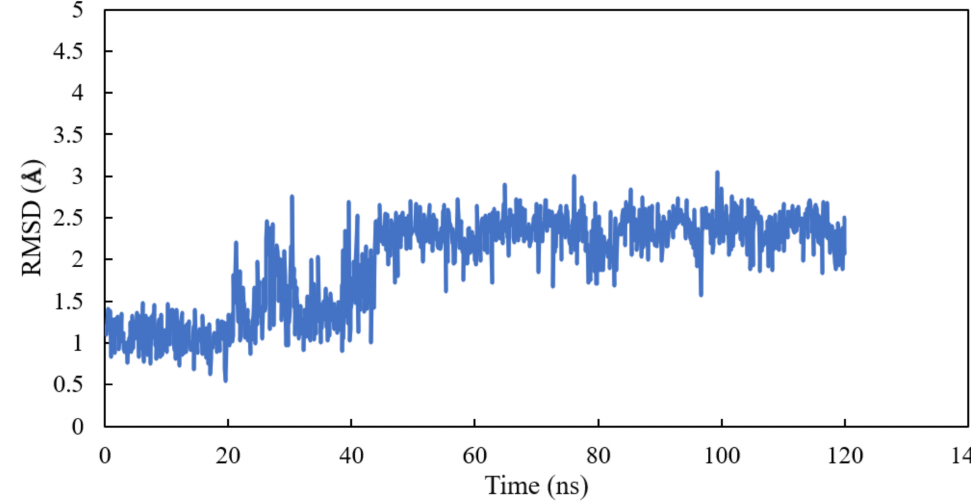
Figure 5. RMSD of scoulerine in the colchicine binding site.